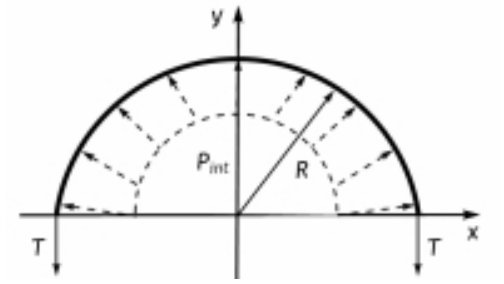
Fig. 2. Free-body diagram of a half ring under internal